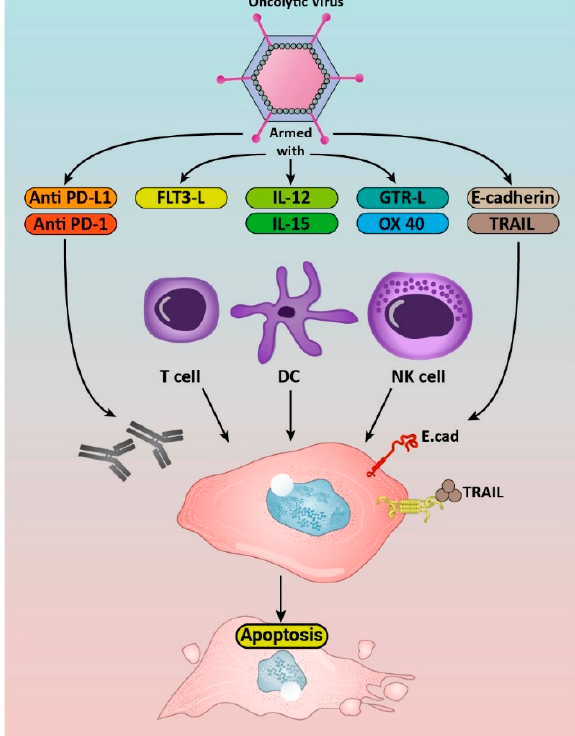
Figure 2. Schematic representation of armed oncolytic viruses against Glioblastoma. OVs express immunomodulatory transgenes: interleukins (IL 12,15), TRAIL and Flt3L. OVs express immune checkpoint inhibitors (anti-PD-L, anti-PD-1). OVs express immune stimulators (GITRL, OX40). OVs express E-cadherin.